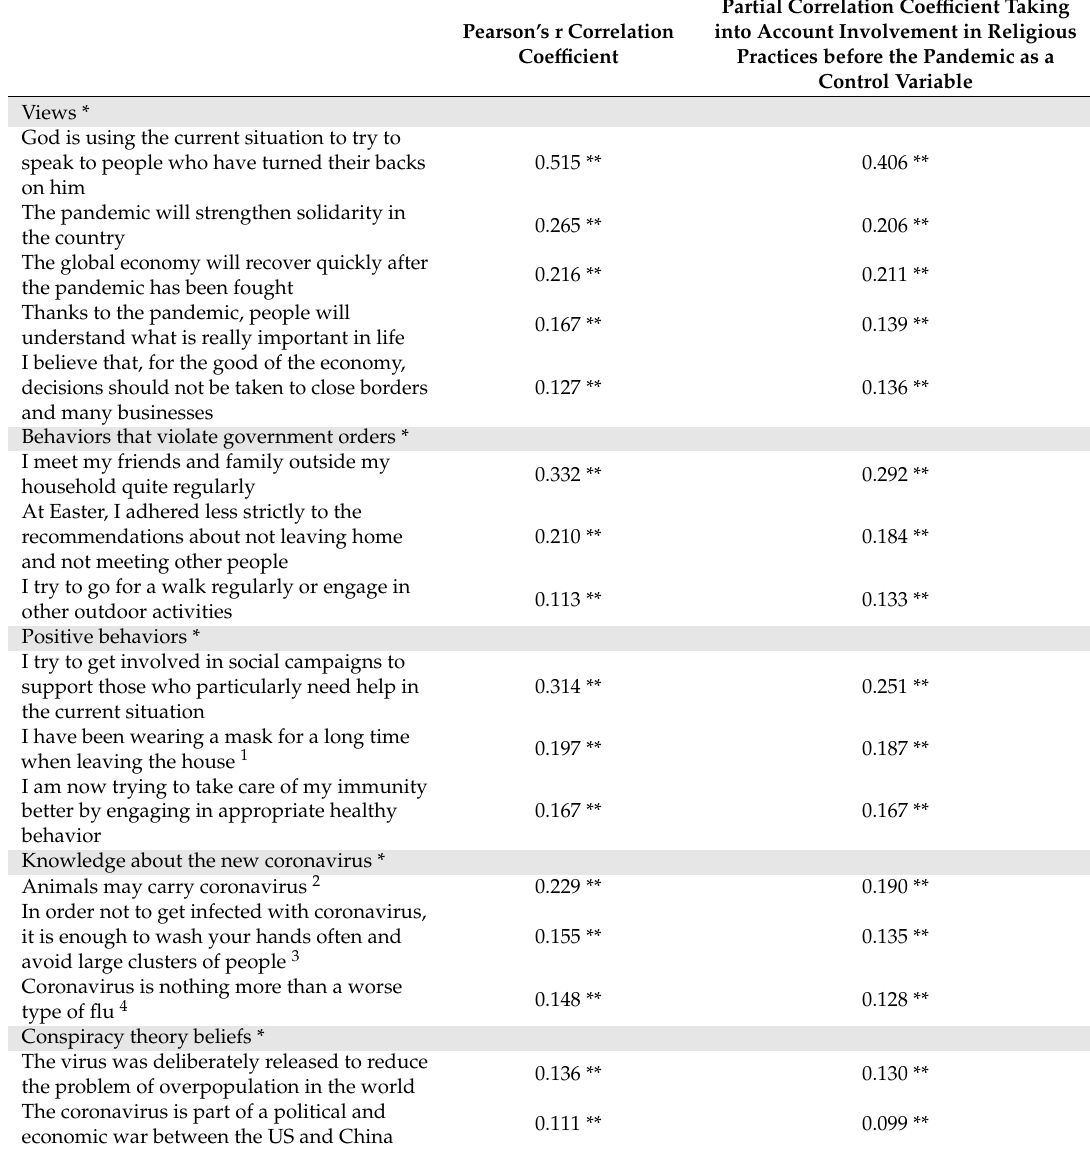
Table 2. Correlates of increased religious involvement during the pandemic as measured by responses expressing agreement or disagreement with the statement “I now devote more time than before to prayer and other religious practices” (on a 5-point scale ranging from “definitely no” to “definitely yes”). Partial Correlation Coe ffi cient Taking Pearson’s r Correlation into Account Involvement in Religious Practices before the Pandemic as a Coe ffi cient Control